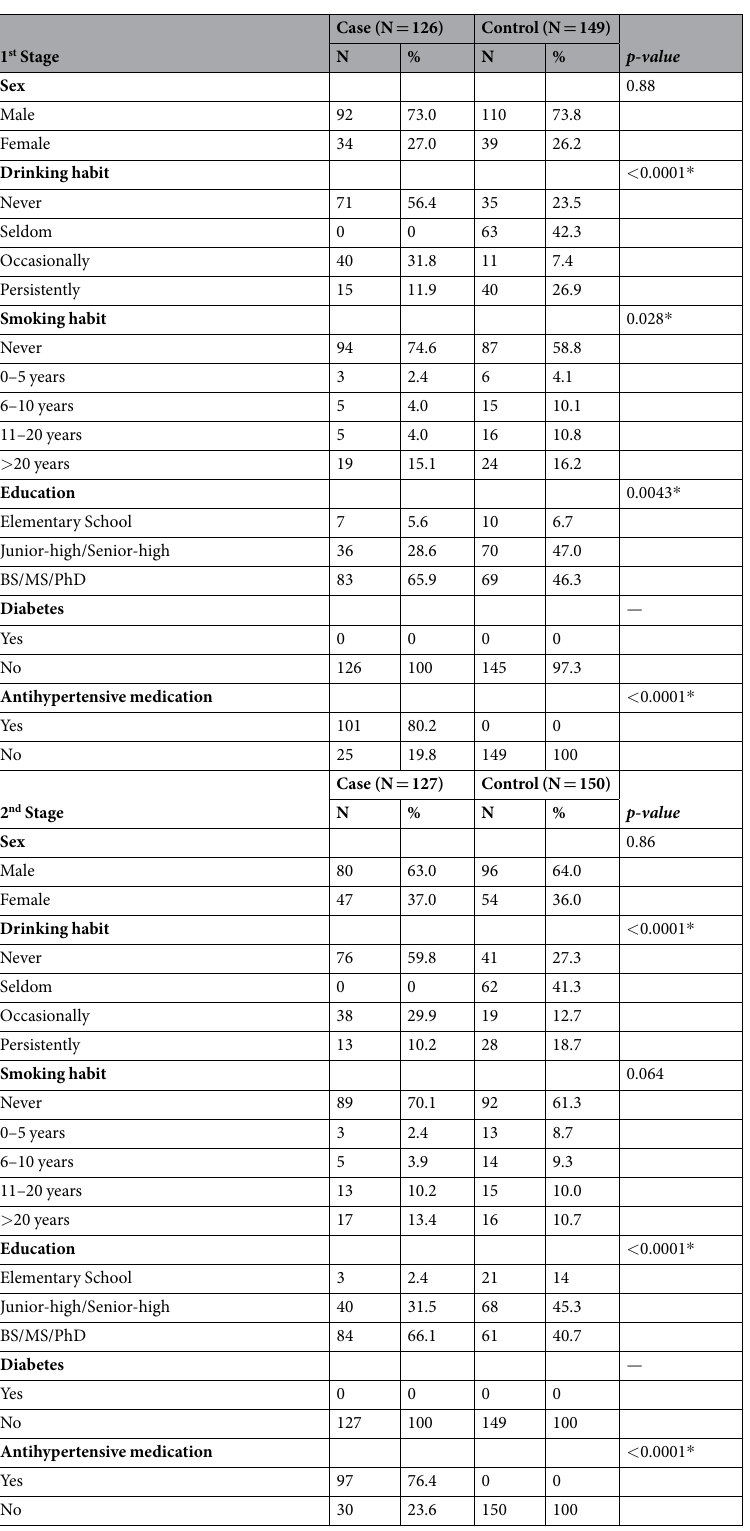
Table 2. Characteristics of participants – categorical traits. * p <